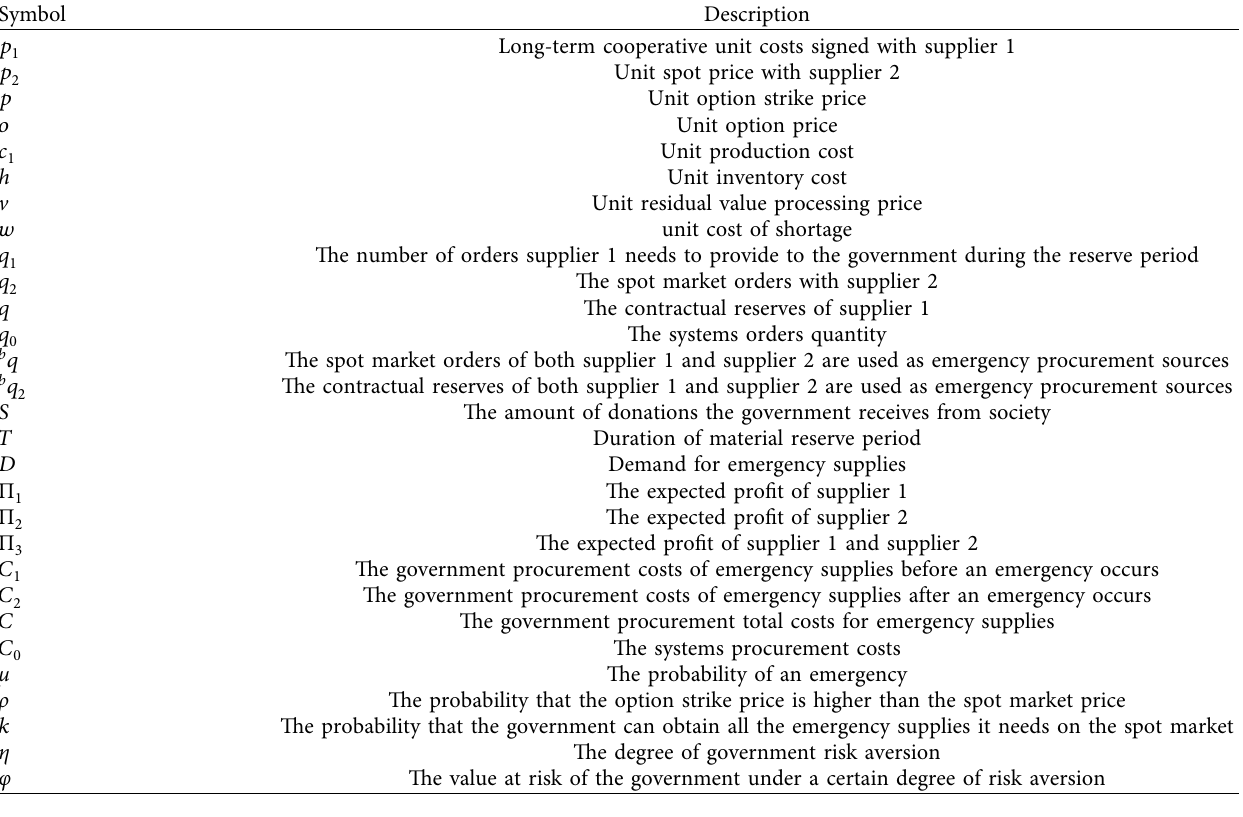
Table 1: Parameter symbols